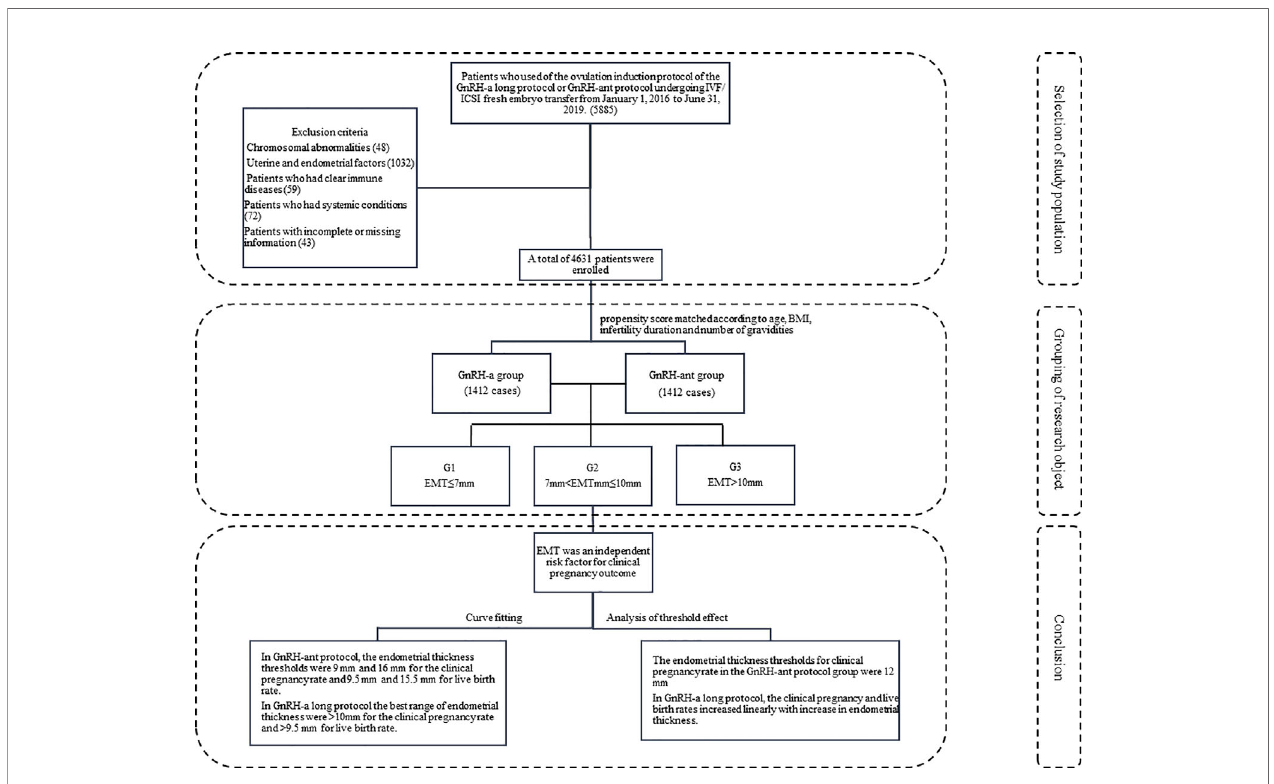
FIGURE 1 | Flow diagram of selection process and